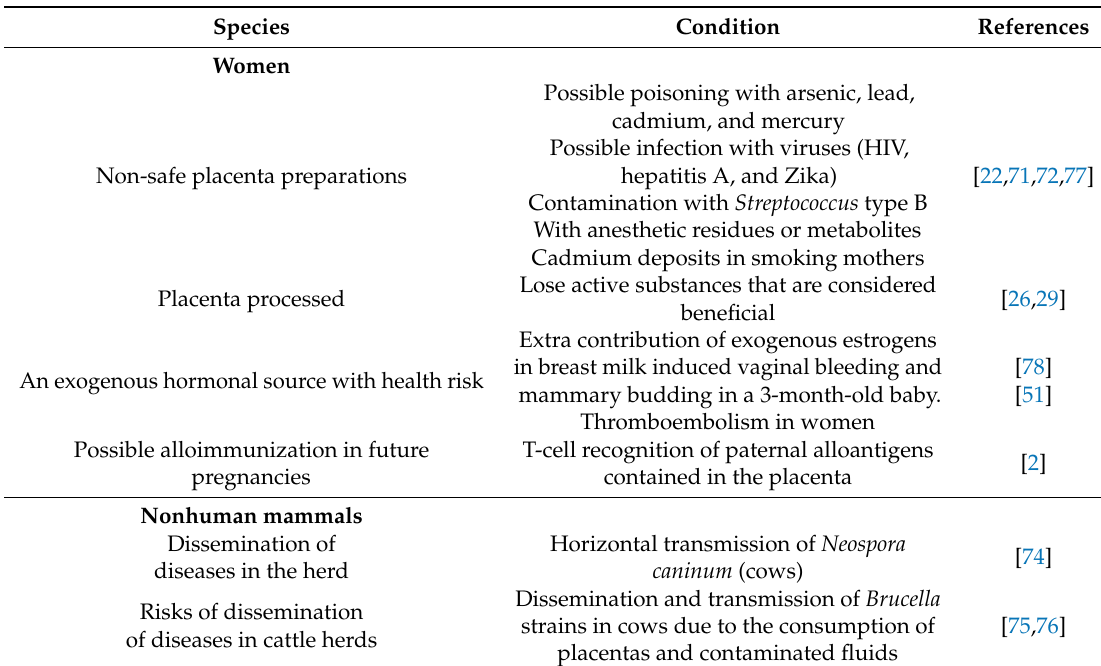
Table 2. Potential disadvantages of placentophagia in women and non-human